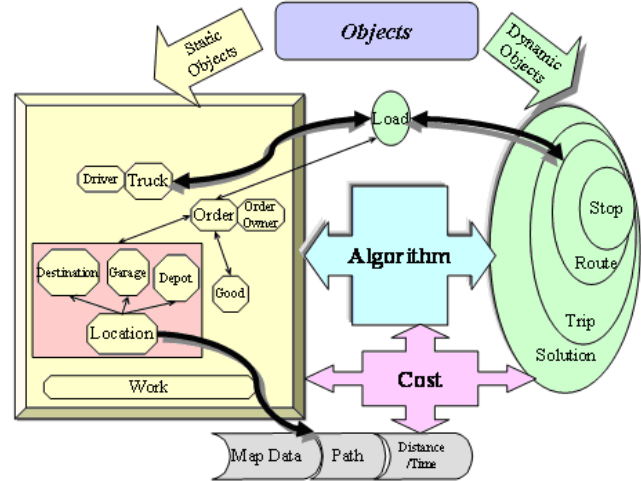
Figure 3: The VRSP objects map used in CARS